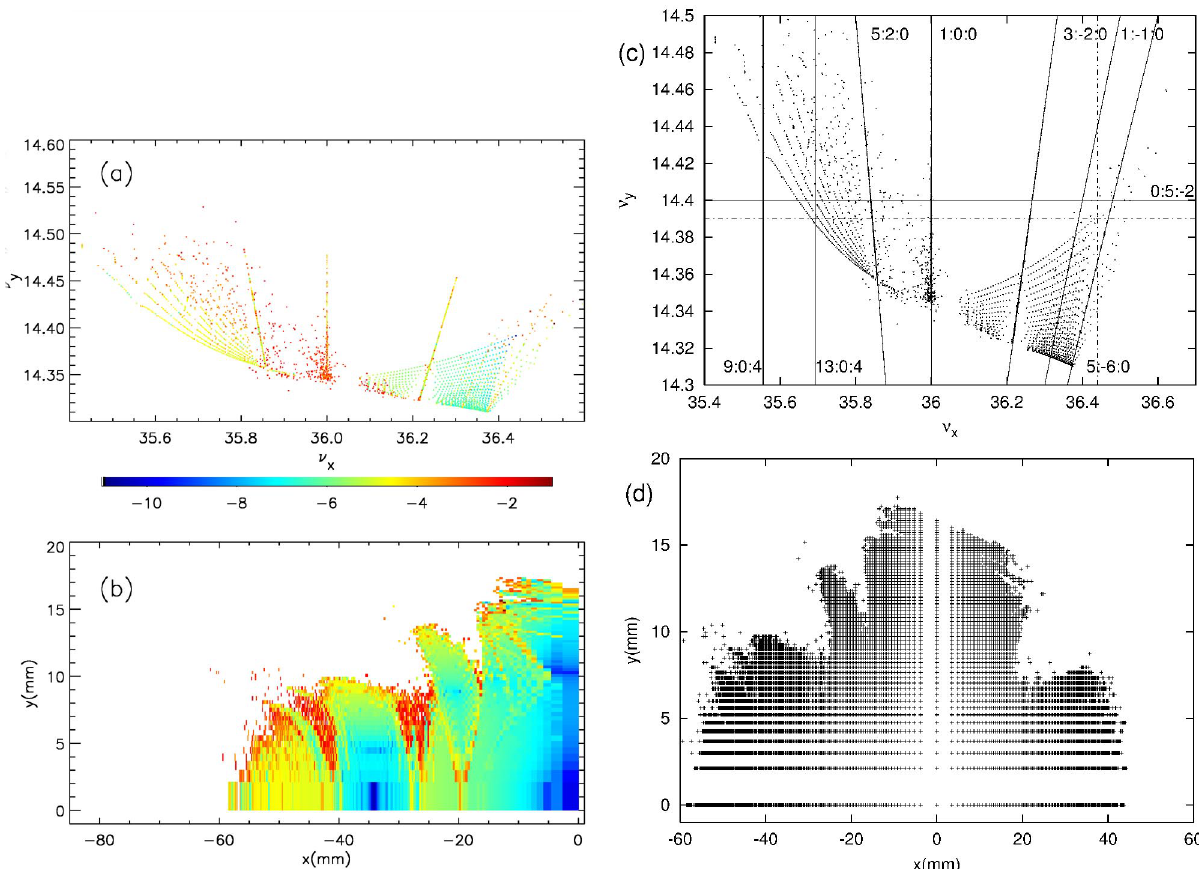
FIG. 10. (Color) ESRF frequency map (a) and dynamic aperture (b) for the first sextupole set computed for the Poincare´ surface (cid:1) 35 : 6 m and (cid:28) (cid:1) 2 : 5 m ). Although very large, the DA is irregular and distorted by many resonances and dominated by s (cid:1) 0 ( (cid:28) x y (cid:12) 36 (cid:1) 0 . Resonance network (c) and full dynamic aperture (d). The the coupling resonance 3: (cid:12) 2:0 and the integer resonance (cid:1) x working point is shown by the dashed line cross.